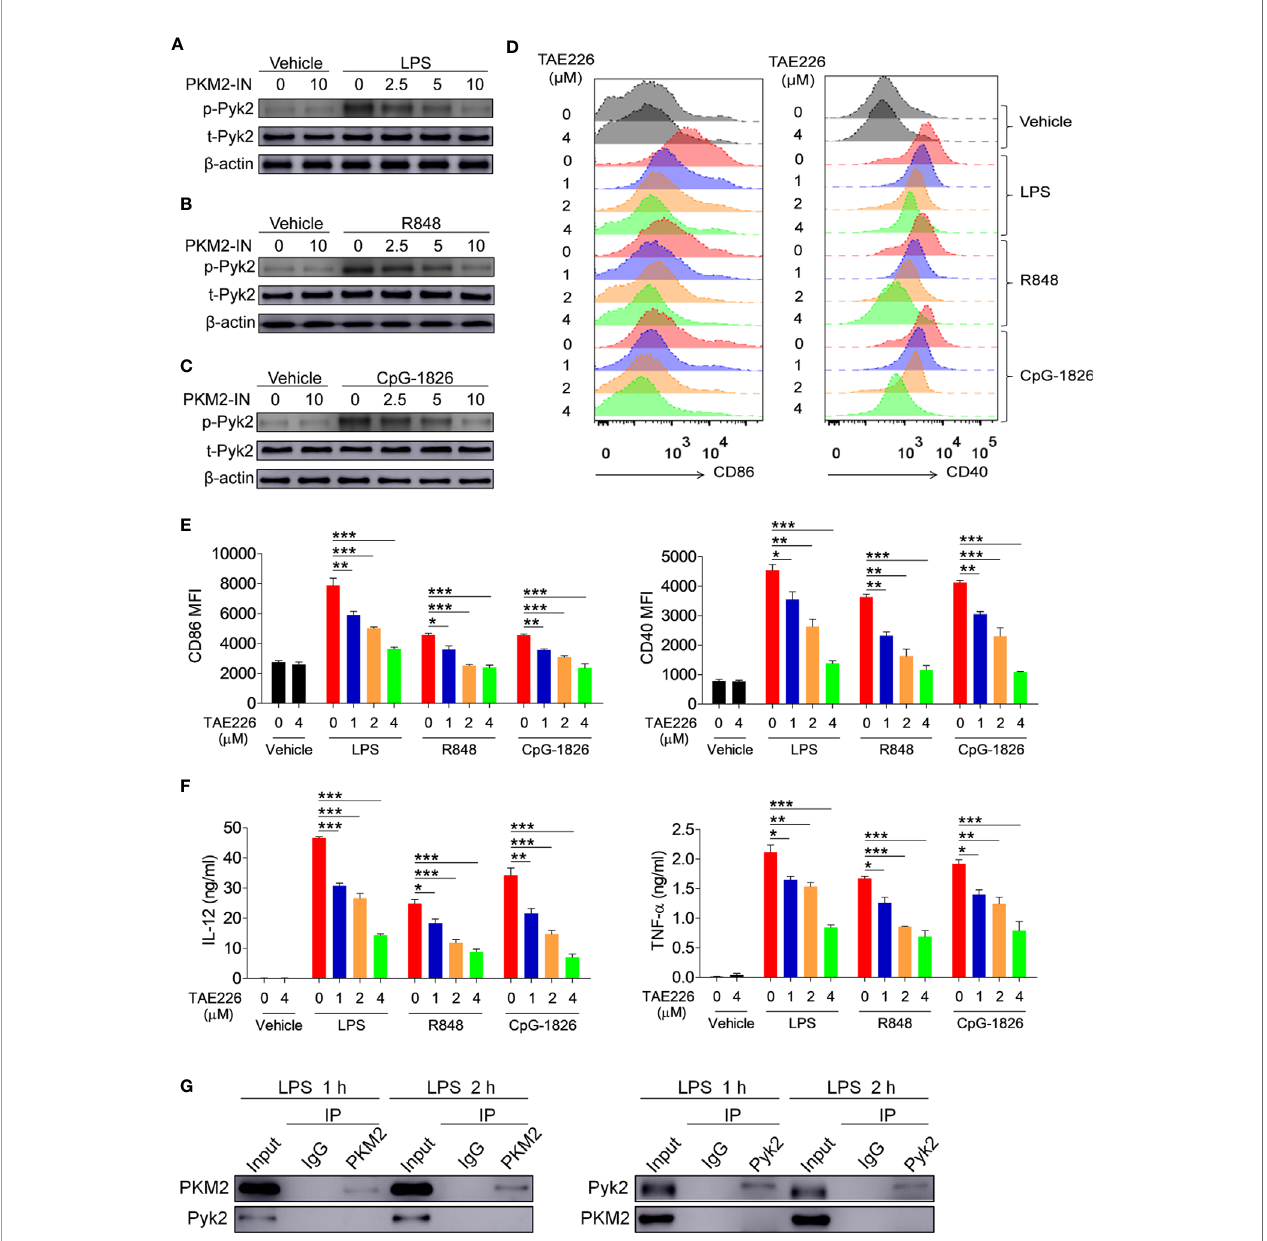
FIGURE 5 | PKM2 augments the activations of TLR4/TLR7/TLR9 pathways by promoting Pyk2 activation. (A – C) BMDMs were treated with PKM2-IN (2.5, 5, 10 m M) for 2 hours followed by stimulations of LPS (100 ng/mL), R848 (1 m g/mL) and CpG-1826 (1 m M). Western blot analysis of the phosphorylation levels of Pyk2 at 1 hour. (D – F) BMDMs were treated with TAE226 (1, 2, 4 m M) for 2 hours followed by stimulations of LPS (100 ng/mL), R848 (1 m g/mL) and CpG-1826 (1 m M). FACS analysis of CD86 and CD40 expression at 24 hours (D, E) . ELISA analysis of the levels of IL-12 and TNF- a secreted by BMDMs at 24 hours (F) . (G) Co-IP analysis of the interaction between PKM2 and Pyk2. The data shown represent the means of three independent experiments and the error bars represent the S.E.M. * p < 0.05, ** p < 0.01, *** p < 0.001, as determined by ANOVA